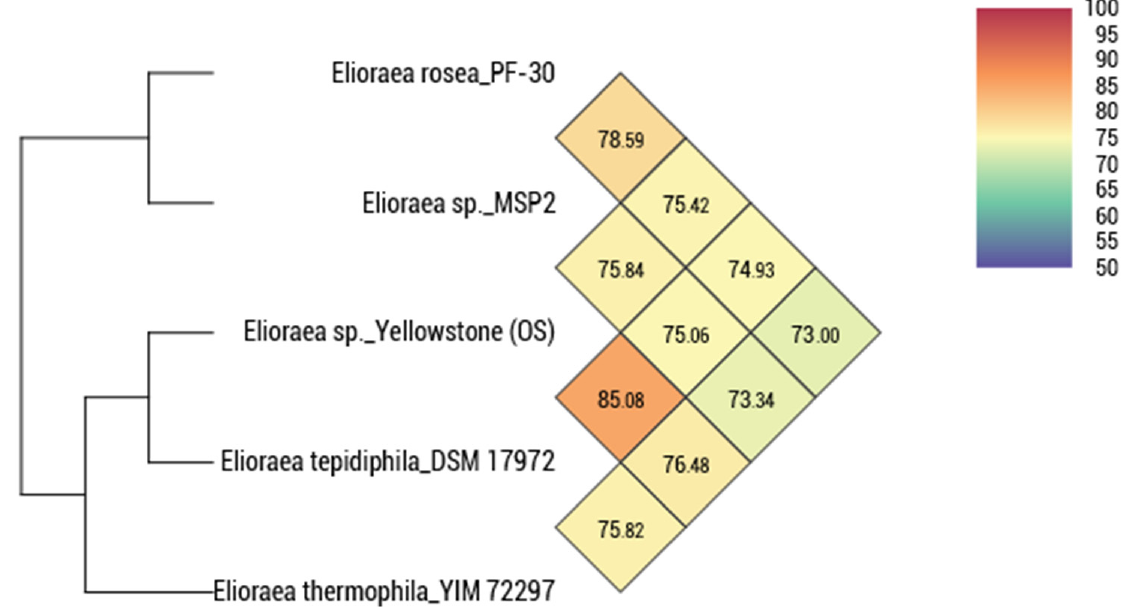
Figure 4. Heat-map and cladogram showing the average nucleotide identity (ANI) values for pairwise comparisons of the genome sequences of five Elioraea spp. strains. Elioraea sp. strain MS-P2 T is very slightly more closely related to E. rosea (78.59%) than to the other strains. Otherwise, all pairs are roughly equally dissimilar except for E. tepidiphila and Elioraea sp. “Yellowstone”. However, the values for all comparisons are well below the threshold of 95–96 ANI expected for members of the same species.